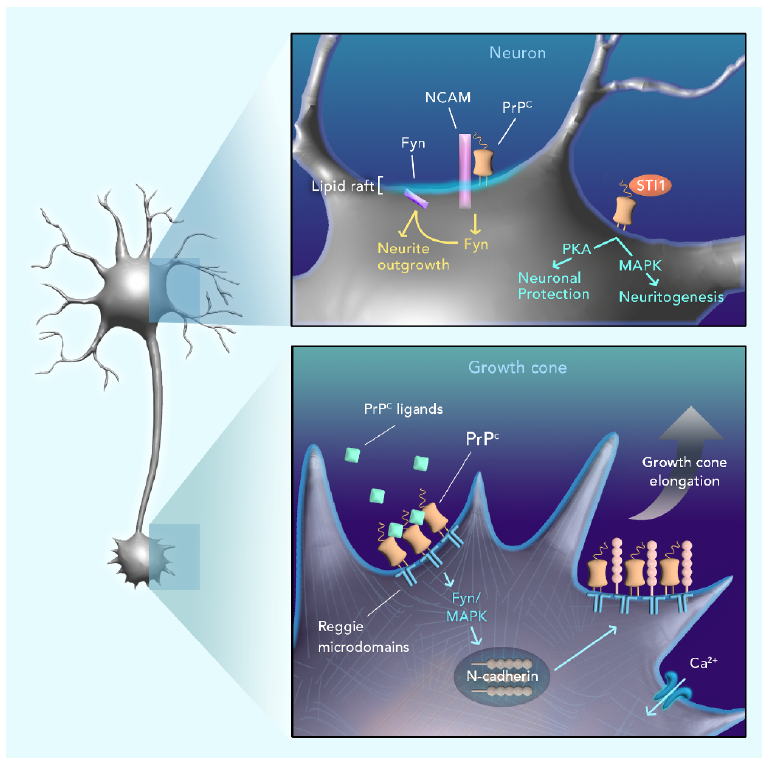
Figure 2. Role of PrP C in neuronal plasticity. Upper panel: PrP C seems to interact with neural